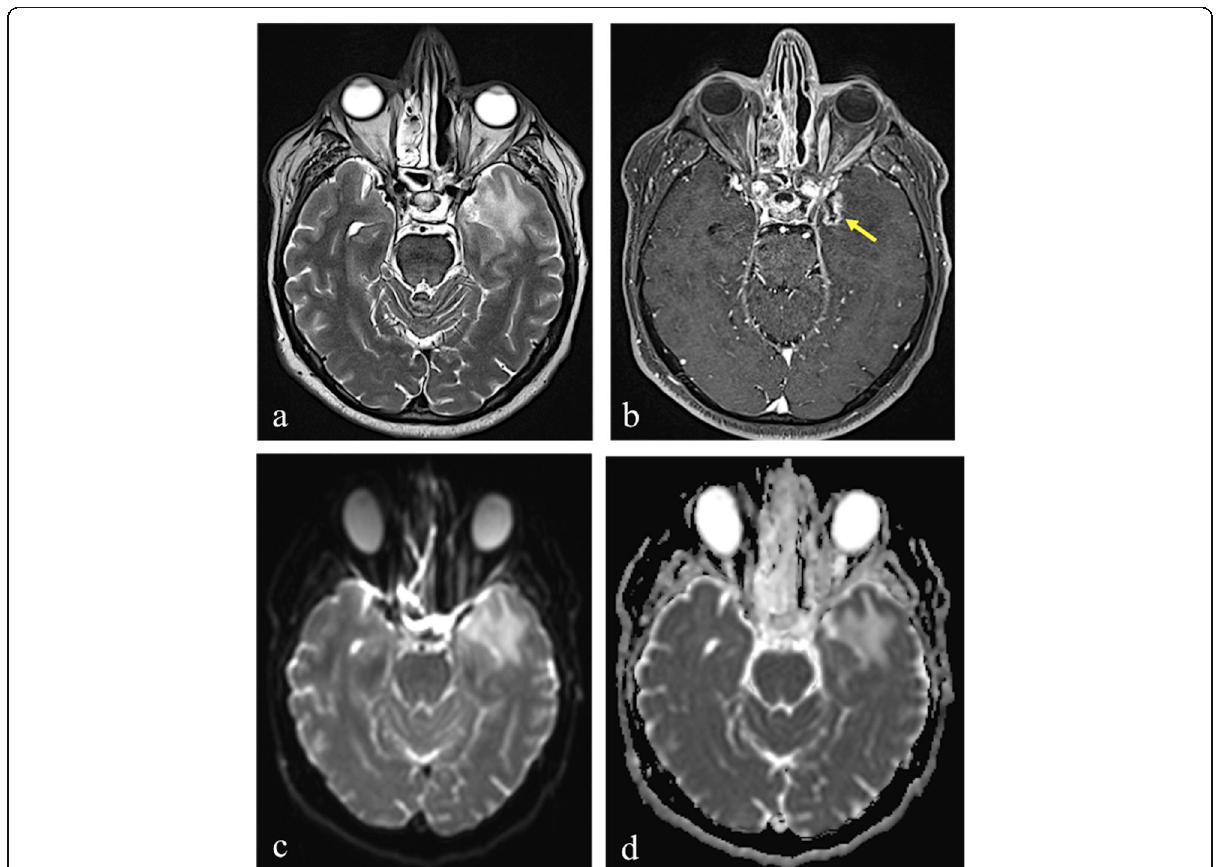
Fig. 2 MRI performed 20 months after 68.8 Gy carbon ion therapy in a patient who previously underwent surgical resection for sinonasal adenoid cystic carcinoma. Axial T2-weighted image ( a ) shows hyperintensy involving subcortical white matter and gray matter in left polar and mesial temporal regions. Axial post-contrast T1-weighted image ( b ) reveals the presence of a well-defined contrast-enhancing lesion with central necrotic core (yellow arrow), as in grade 2 injury of LENT-SOMA scoring system. DWI shows no diffusion restriction within the enhancing area, with an hyperintense signal in both DWI - b1000 ( c ) and ADC map ( d ), because of “ T2-shine through ”